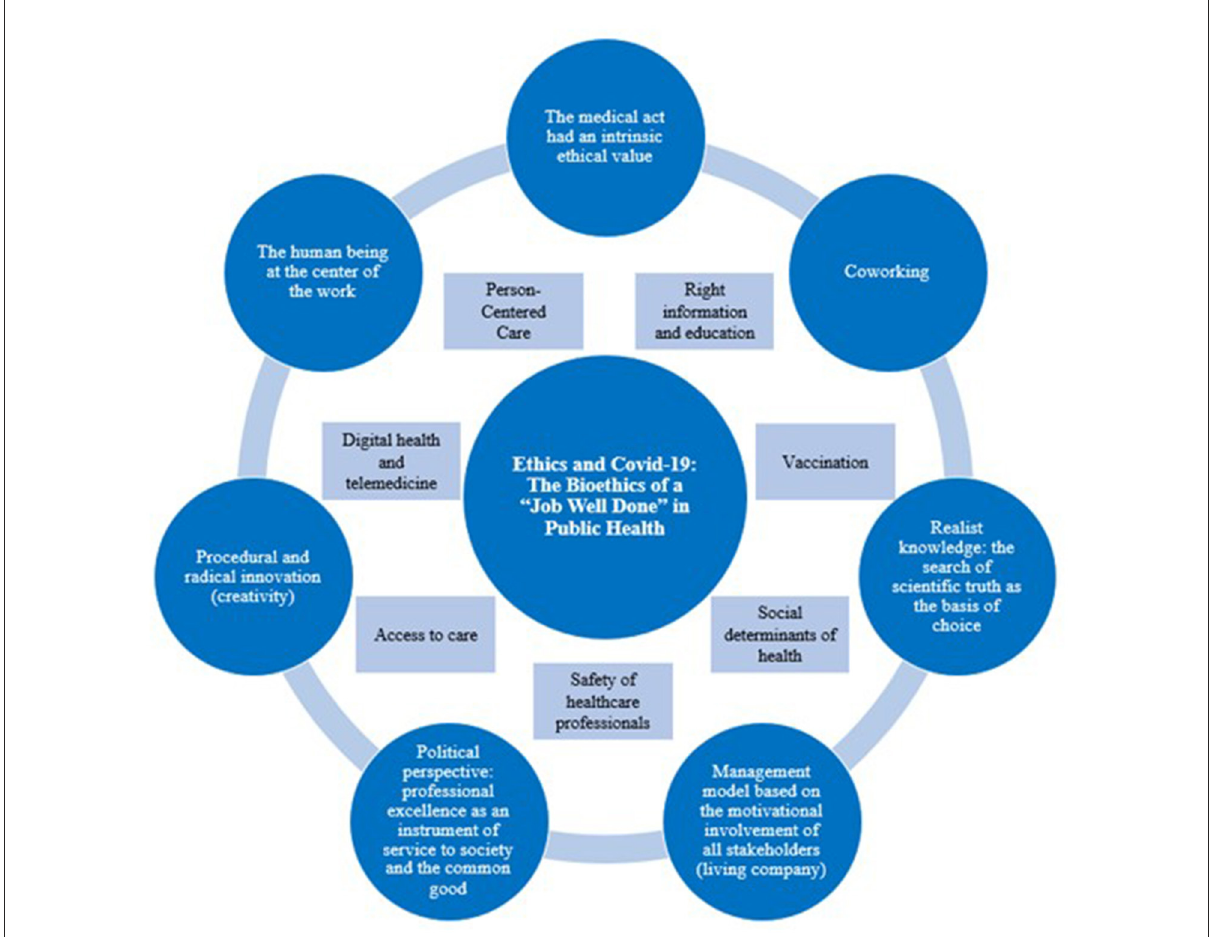
FIGURE1 The main themes that emerged from the Research Topic with respect to the “Ethics of Job Well Done framework” (De Micco et al.,